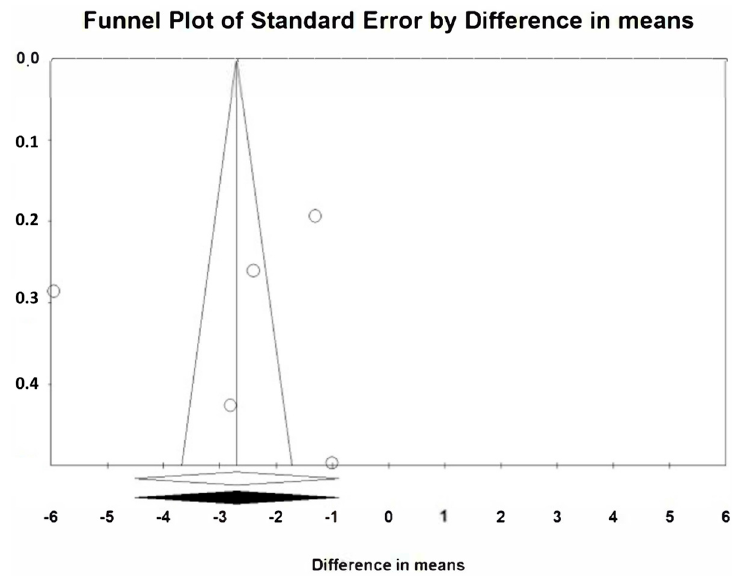
Figure 8. Publication bias at three months.